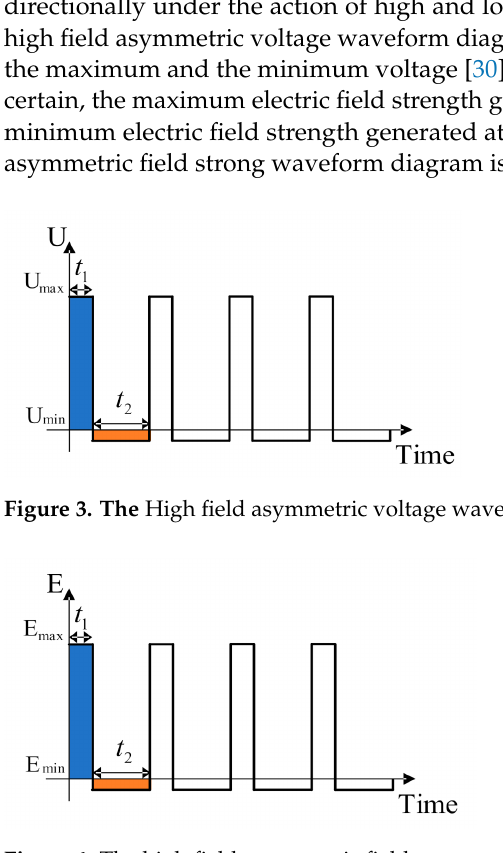
Figure 4. The high field asymmetric field strong waveform